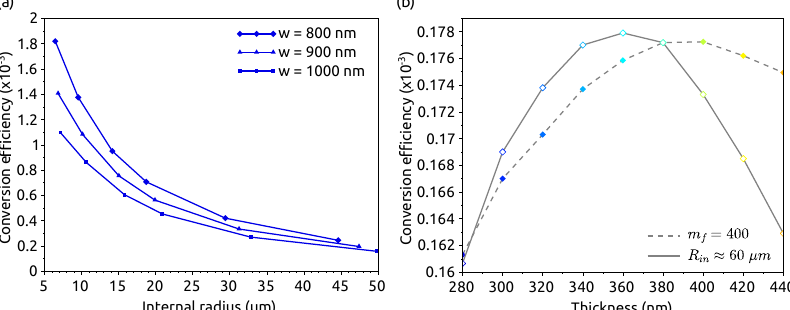
Figure 3. SHG conversion efficiency in Si microring cladded by Si 3 N 4 . The pump power is P in = 1 mW, ( 2 ) = 1 pm/V, and the intrinsic and coupling Q-factors are 10 4 . ( a ) Varying the internal radius R χ zxy for a fixed thickness e = 280 nm and different widths w . ( b ) Varying the thickness e , for a fixed width w = 800 nm and a fixed internal radius ( R in ≈ 60 µ m) or a fixed fundamental azimuthal number ( m f = 400) and different